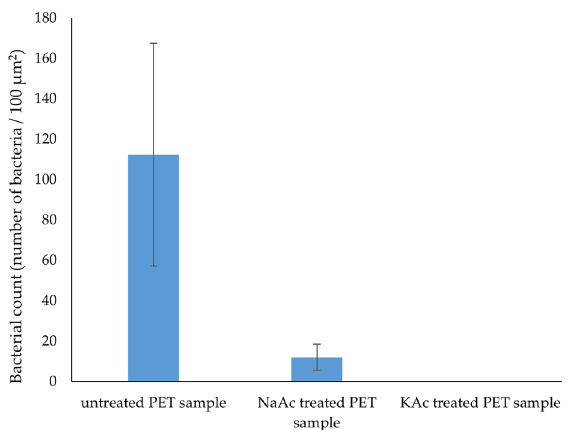
Figure 8. Number of bacteria (determined by the flourescence microscopy analysis) that attached to the untreated and treated PET surfaces after incubation for 4 h. The data are presented as means ± SDs (n = 6).